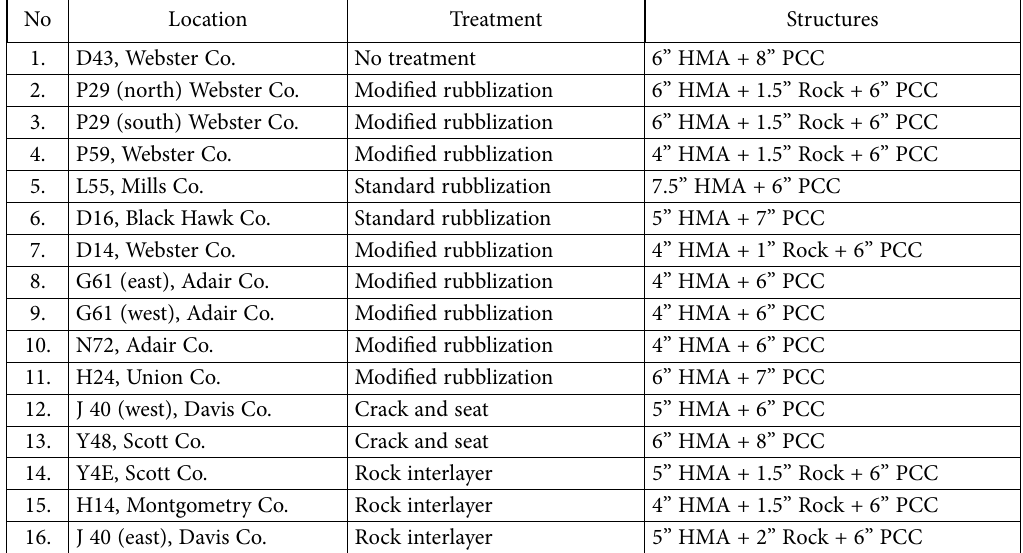
Table 1. Details for sixteen pavement sections tested (1” = 25.4